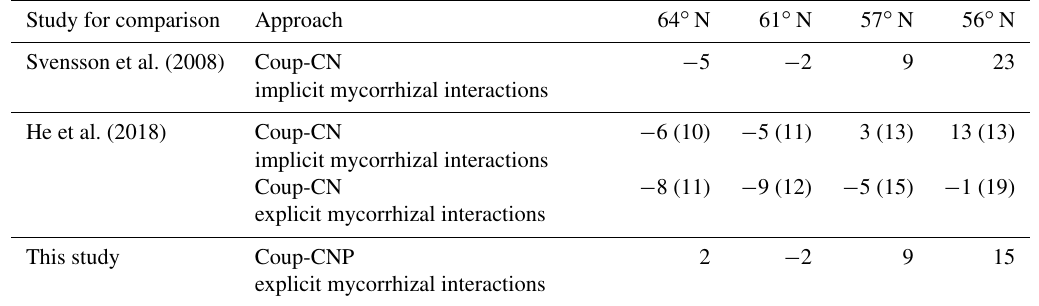
Table 5. Simulated annual average soil C changes (gCm − 2 yr − 1 ), positive mean sequestration, negative mean losses), including comparison with previously reported results. Values in parentheses indicate uncertainties due to certain model